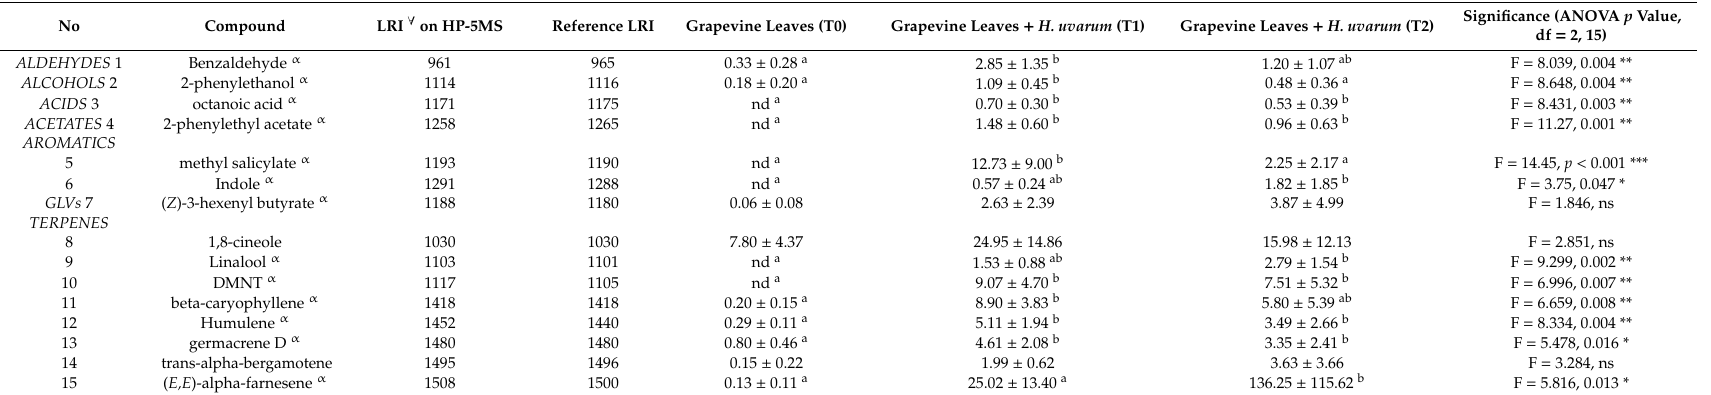
Linear Retention Indices as calculated from experimental retention times; † The amount in TIC of each compound in the yeast cultures is the mean peak area of six replicates; mean ± standard deviation, divided by 10 6 (in TIC / 3 h) of volatile compounds calculated from six replicates. α VOCs confirmed by comparison with reference